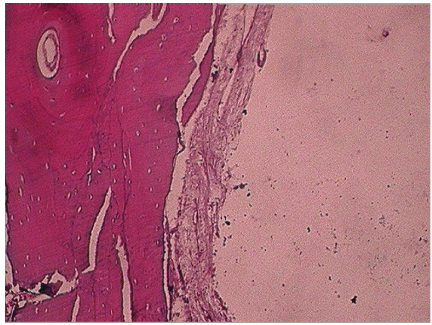
Figure 4: H&E stained section of the curetted tissue exhibits osseous cystic wall and overlying fibrovascular tissue with no epithelial lining.